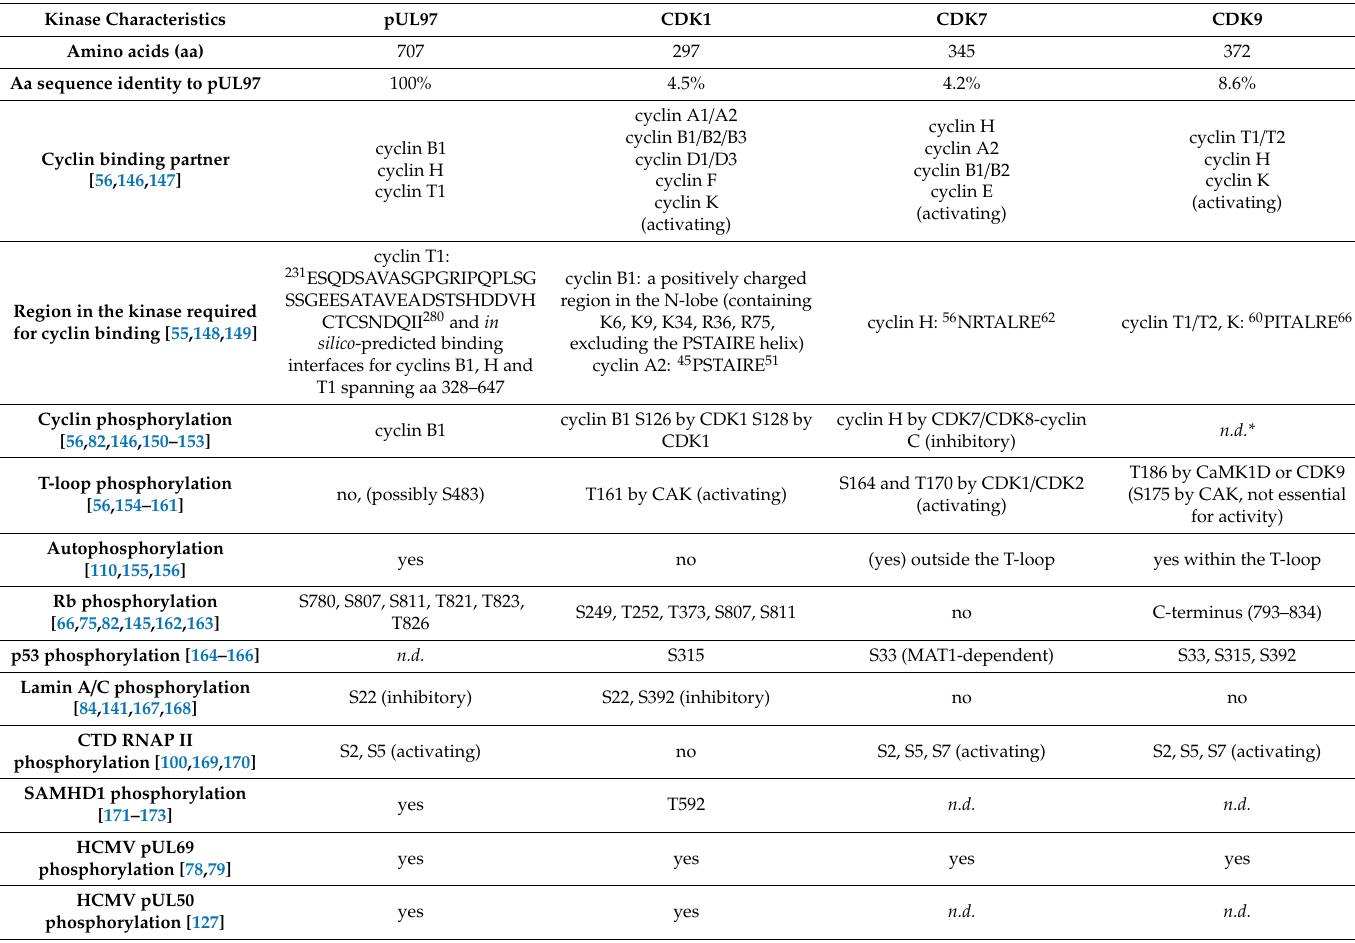
Table 4. Comparison of distinct molecular characteristics shared between vCDK pUL97 and human